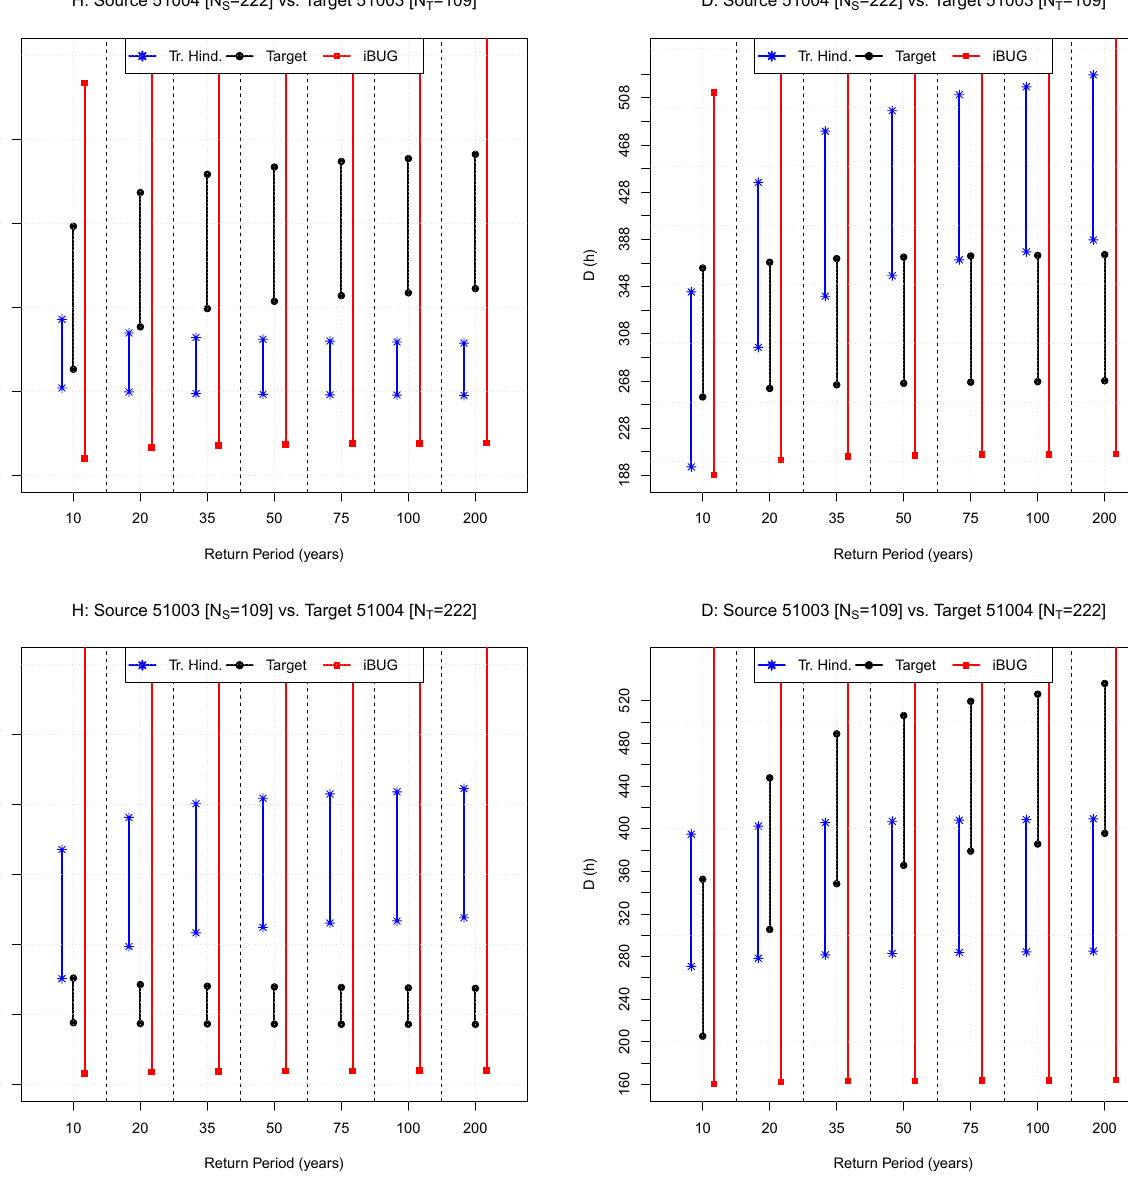
Figure 5. Comparison of design values: the Hawaii case. The plot shows the CI’s of the Target design values (black) associated with the RP’s indicated on the horizontal axis. The blue and red CI’s represent, respectively, the corresponding estimates computed via the Traditional Hindcasting and the iBUG techniques. The variables of interest ( H and D ) are indicated in the title, as well as the labels of the buoys considered and the Source ( N S ) and Target ( N T ) sample